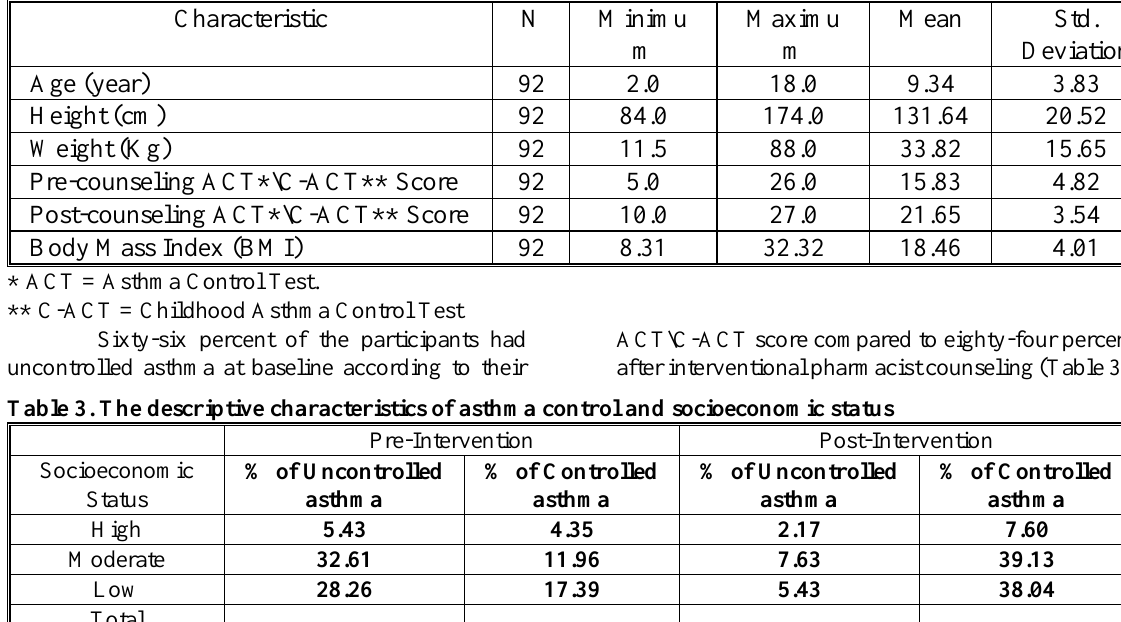
Table 2.The descriptive characteristics of the participating patients